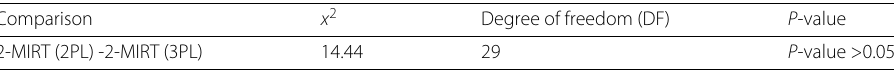
Table 12 Chi-square tests comparing the fit of 2-MIRT (2PL) and 2-MIRT (3PL) models Comparison x 2 Degree of freedom (DF) P -value 2-MIRT (2PL) -2-MIRT (3PL) 14.44 29 P -value >0.05